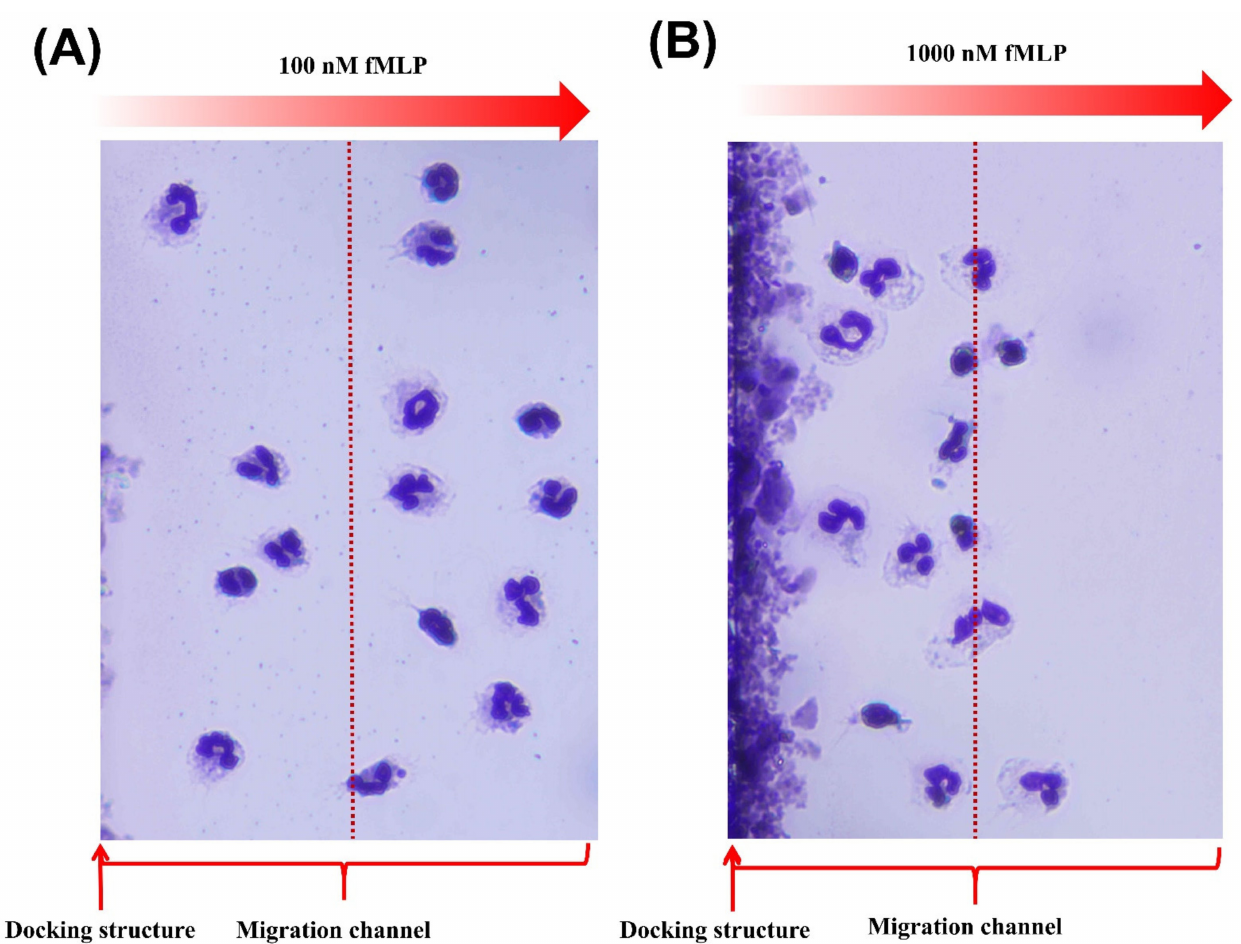
Figure 5. Giemsa images of the neutrophils in the migration channel. ( A ) The cell images at 15 min in 100 nM fMLP gradient. ( B ) The cell images at 15 min in 1000 nM fMLP